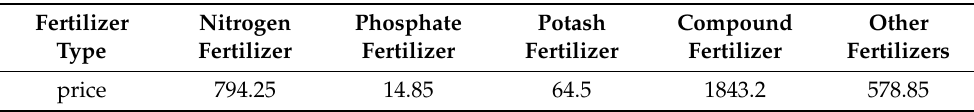
Table 2. Fertilizer price of cotton per hectare (yuan /hm 2